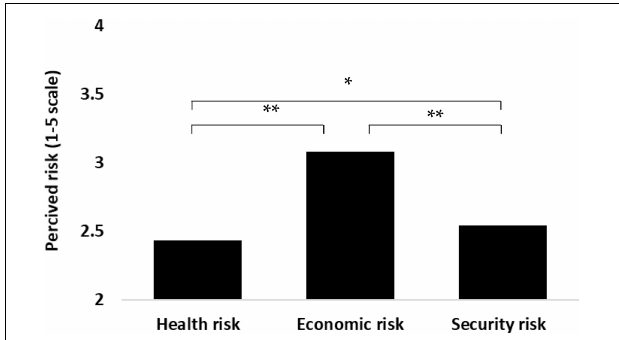
FIGURE 1 | One-way repeated measures analysis of variance (ANOVA) of the three perceived risks. * p < 0.05, ** p <